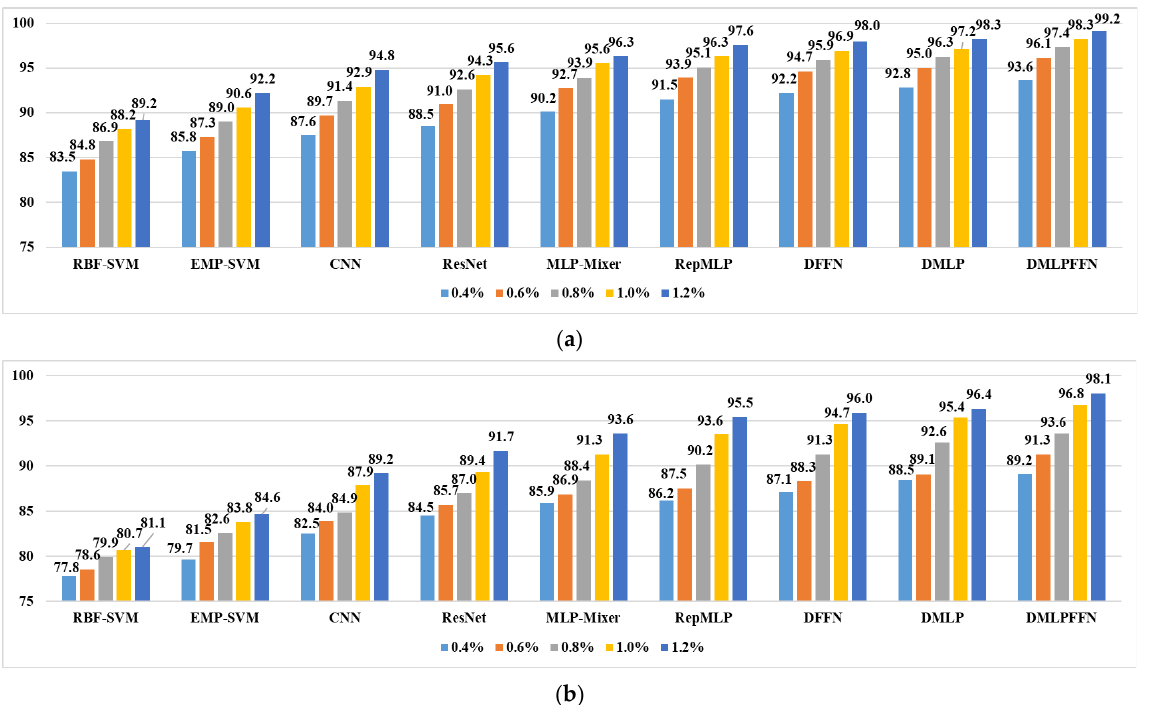
Figure 13. Comparison of the different number of training samples under different methods. ( a ) LongKou; ( b ) HanChuan.